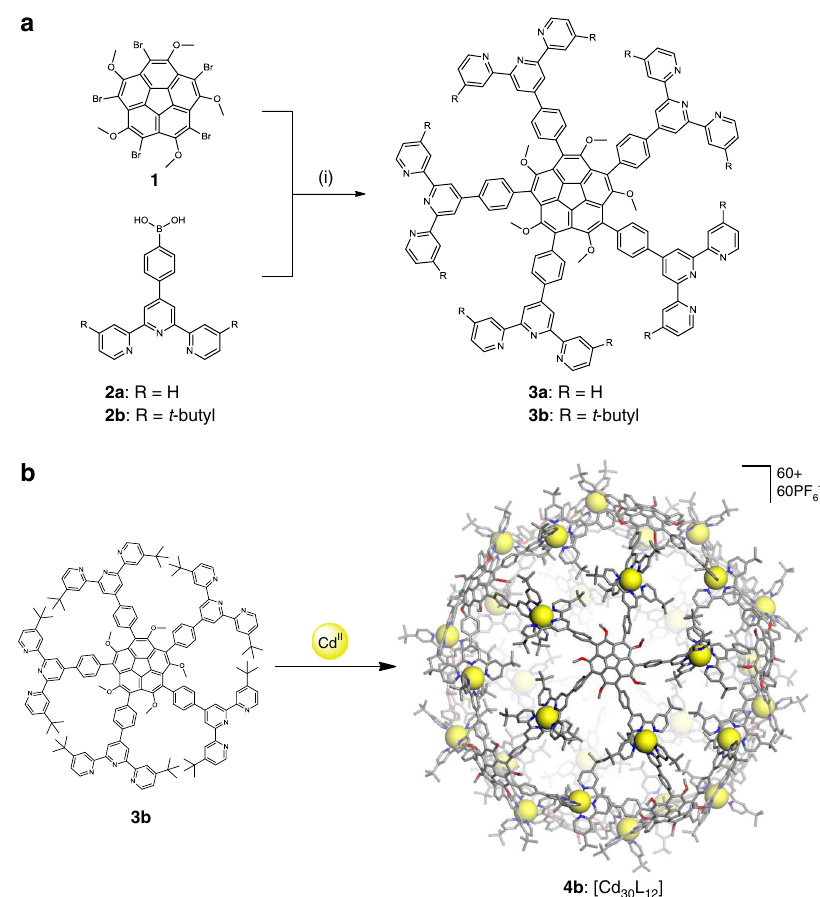
Fig. 2 Ligand synthesis and molecular self-assembly. a Reagents and conditions for the synthesis of the corannulene tectons: (i) Na 2 CO 3 , Pd(PPh 3 ) 4 , toluene/H 2 O/ t -BuOH (3/3/1, v/v/v), re fl ux. b Self-assembly of Cd(II) cations with pentatopic tectons, 3b , to produce icosahedron [Cd 30 L 12 ], 4b . Supplementary Movie 1 shows the geometry-optimized capsid